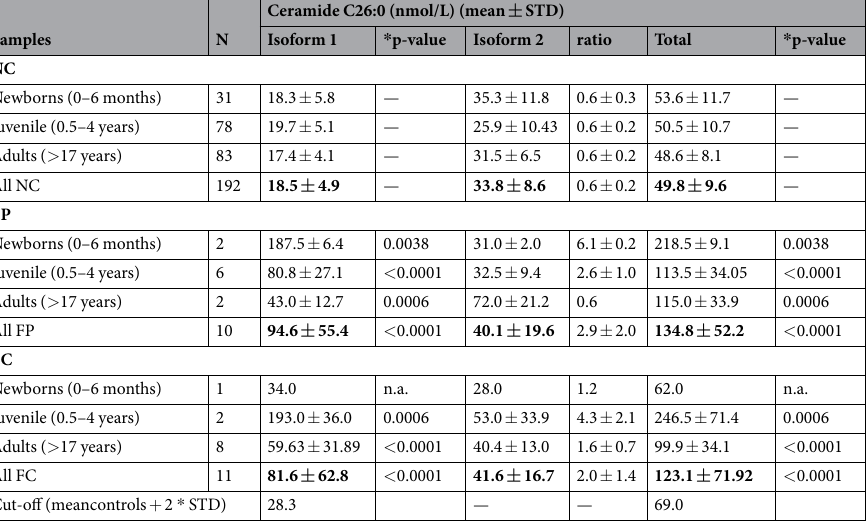
(Table 2, Fig. 3). In FC both isoforms of C26:0 exhibited normal levels in newborn carriers, increasing, however, to patholog- ical levels in juveniles (especially isoform 1). Interestingly, in adults the concentrations of both isoforms were decreased compared to juveniles, but still higher than values seen NC adults (Fig. 3). Taken together, these results (Table 2, Fig. 3) clearly demonstrate elevated levels of C26:0 in every age group of FP. Quantitative data show that this increase was predominantly caused by alterations of isoform 1, making it, along with total C26:0, to specific biomarker for diagnosis of FD.